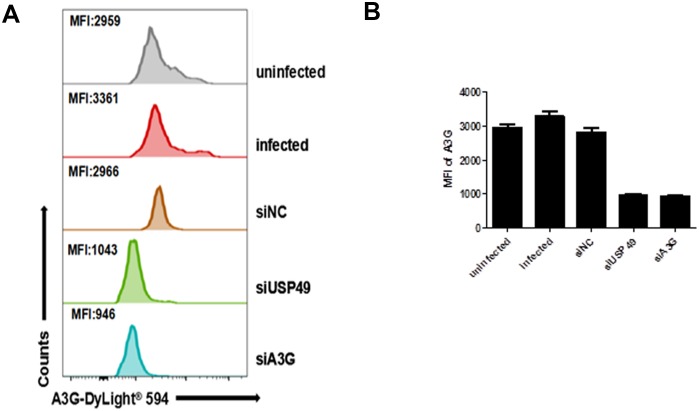
The A3G protein level was detected by flow cytometry.The cells from Figrue 2E were fixed with 80% methanol (5 min) and then permeabilized with 0.1% PBS-Tween for 20 min. The cells were then incubated in 1x PBS/10% normal goat serum/0.3M glycine to block non-specific protein-protein interactions followed by the A3G antibody (Abcam, cat#ab75560) for 30 min at 22°C. The secondary antibody used was DyLight 594 goat anti-mouse IgG (H+L) at 1/500 dilution for 30 min at 22°C. Then these cells were detected by flow cytometry and acquisition of >5000 events was performed. Representative data were shown (A) and error bars represent the SEM of three independent experiments (B).